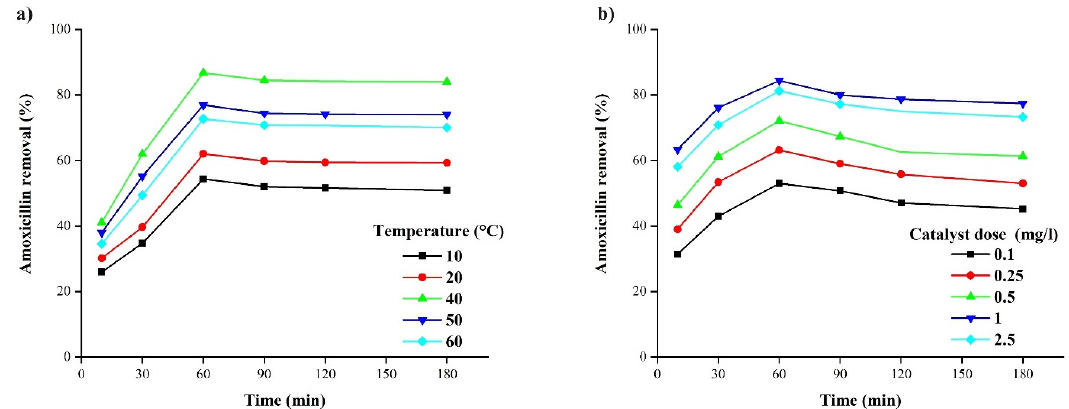
Fig. 3. a. Effect of temperature b. Effect of TiO